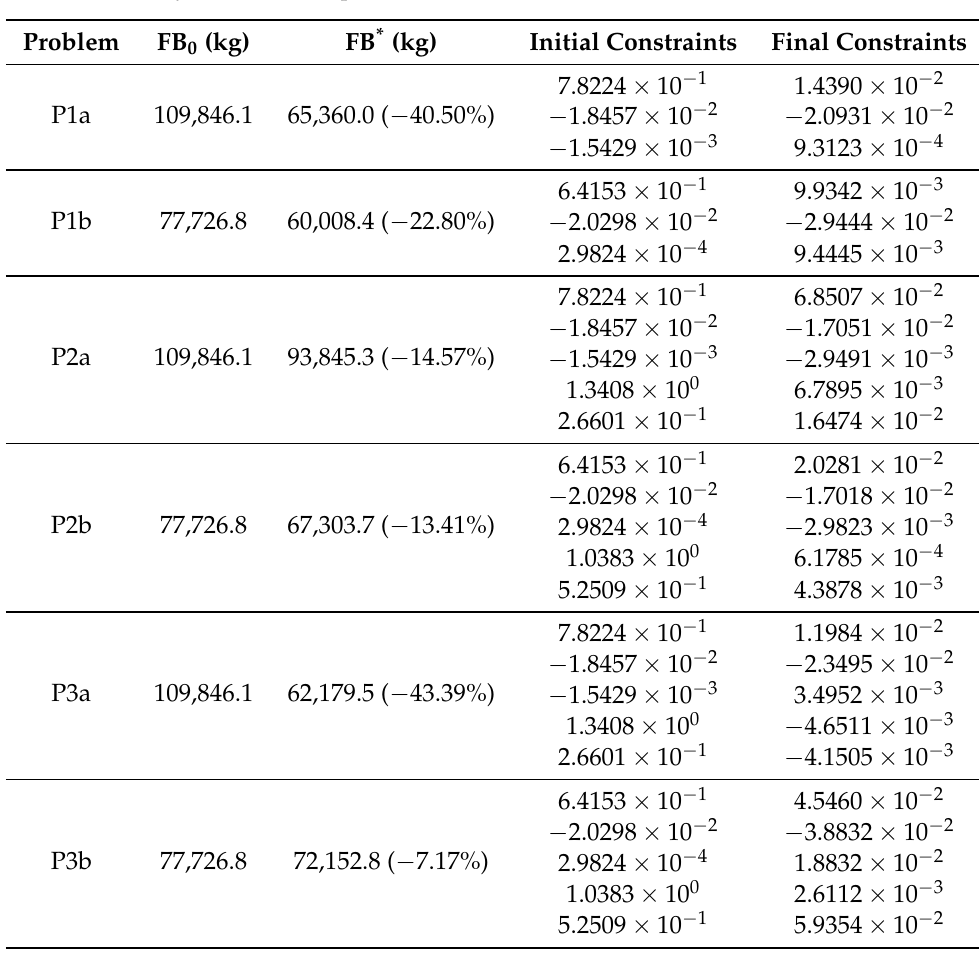
Table 8. Summary of aeroelastic optimization